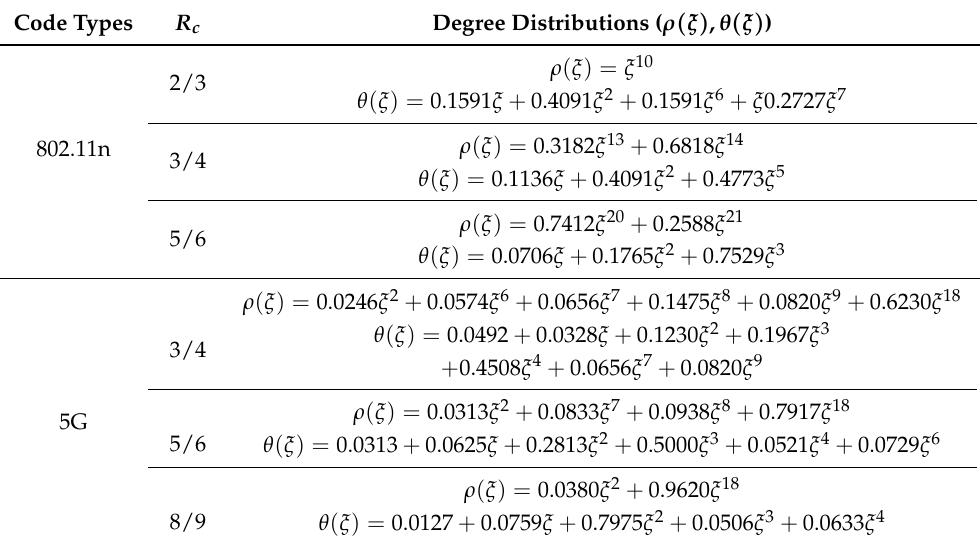
Table 1. Degree Distributions of the IEEE 802.11n LDPC Codes and the 5G LDPC Codes.